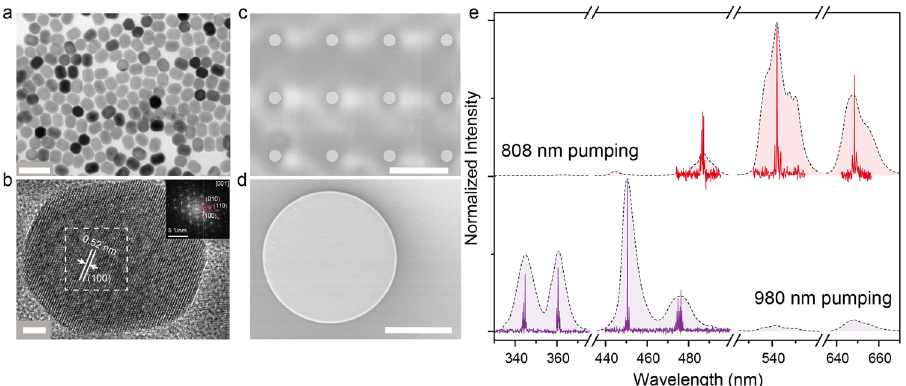
Fig. 2 Realization of UCNCs-based microdisk lasers. a TEM and ( b ) High-resolution TEM images of the NaGdF 4 :Yb/Nd@NaGdF 4 :Yb/Ho@NaYF 4 :Ca@Na YbF 4 :Tm@NaYF 4 :Ca multi-shell nanocrystal. The scale bars are 100 nm and 5 nm, respectively. The inset gives the Fourier transform diffraction pattern of the region indicated in ( b ). SEM images of ( c ) a typical set of UCNCs-based microdisk array, and ( d ) an isolated one (d = ~100 μ m, and t (thickness) = ~300 nm). The scale bars are 500 μ m and 50 μ m, respectively. e The observation of PL spectra (the dotted lines) from the UCNCs solution under CW 808/980 nm excitation at a power of 20 W cm − 2 , respectively. The multiwavelength multimode lasing spectra (the solid red/violet lines) from the UCNCs-based microdisk laser in ( d ) pumped by 808/980 nm pulsed lasers at a power of 93 mJ cm − 2 ,